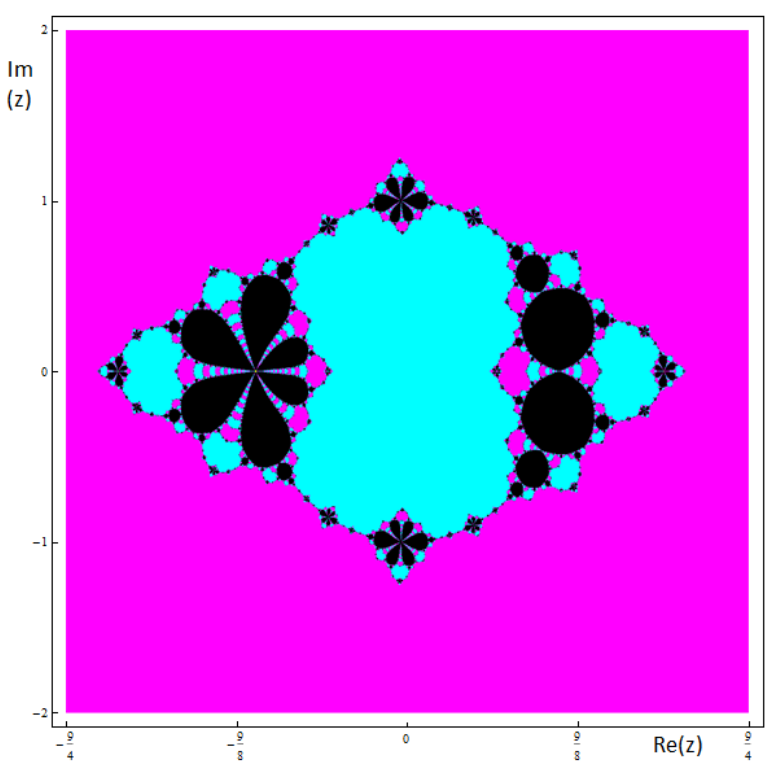
Figure 7. Basins of attraction associated to the member of the family a 0 = 3.25 and a 1 = − 4.5.